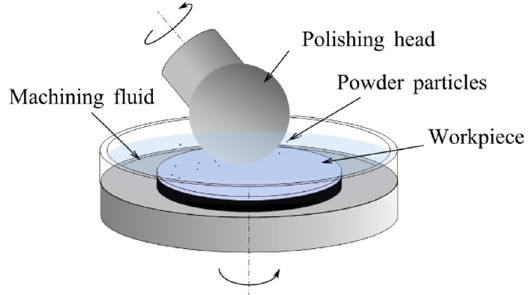
Figure 20. The schematic diagram of elastic emission machining [30].